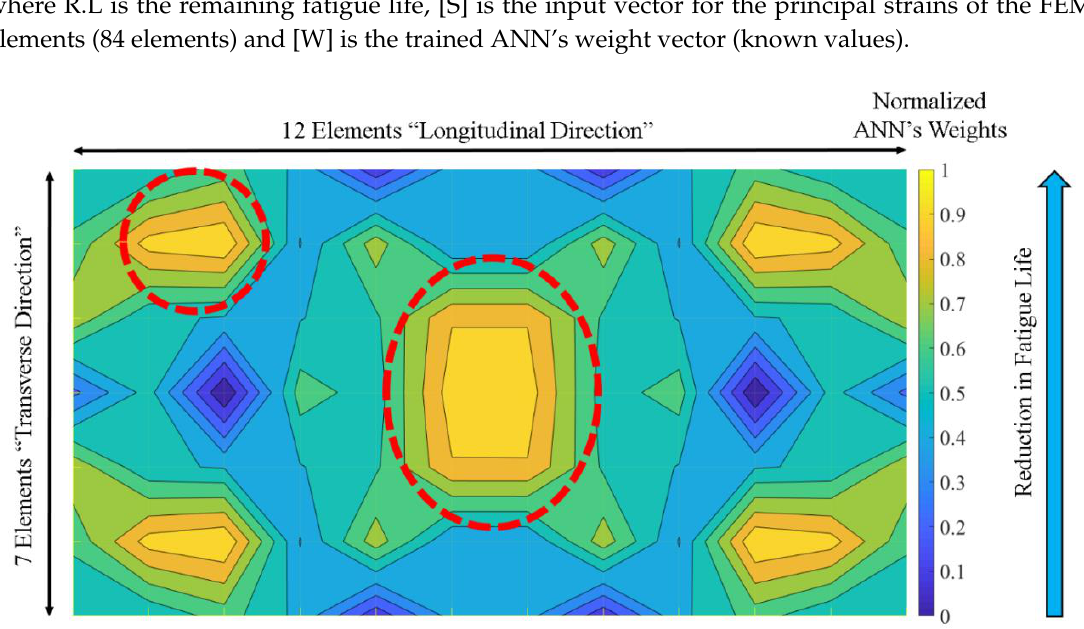
Figure 19. Contours of the cracks location impact on the remaining fatigue life.